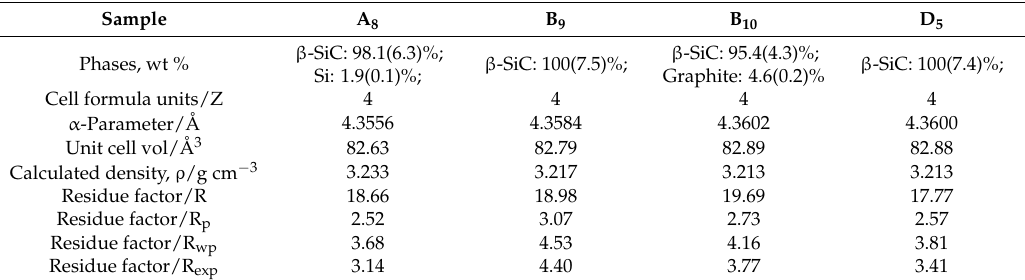
Table 3. Crystallographic data from Rietveld refinements against XRD